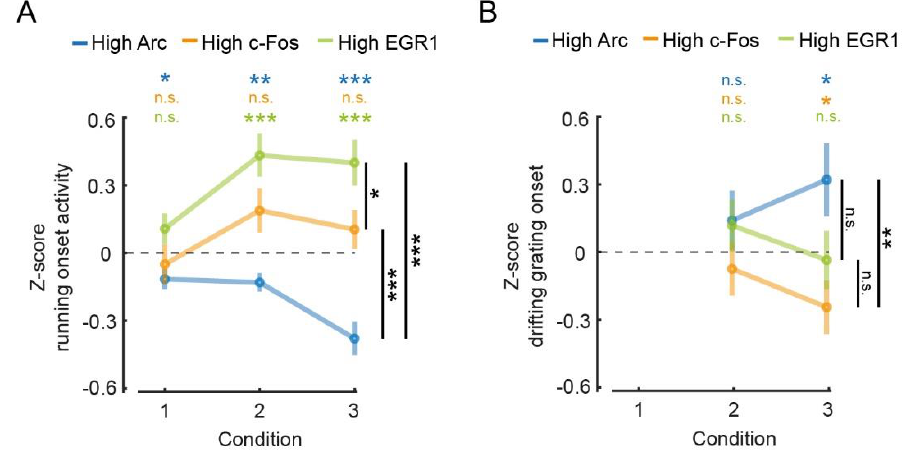
Figure 3. Differential relationship between IEG expression and motor-related and visual responses. ( A ) Average running onset response during darkness for the top 10 % IEG expressing neurons (Arc: 197 neurons, c-Fos: 189 neurons, EGR1: 121 neurons). Neuronal responses were pooled from all experimental sessions for each condition, subtracted by the mean and normalized by the standard deviation of the response of all neurons (Z-score). Error bars are SEM over neurons. Statistics above the plot indicate comparisons against 0, statistics to the right are between-group comparisons. n.s.: p > 0.05, *: p < 0.05, **: p < 0.01, *** p < 0.001, t-test. ( B ) Average grating onset response for the top 10 % IEG expressing neurons (Arc: n = 197, c-Fos: n = 189, EGR1: n = 121). Neuronal responses were pooled from all experimental sessions for conditions 2 and 3, subtracted by the mean and normalized by standard deviation of the response of all neurons (Z-score). Error bars are SEM over neurons. Statistics above the plot indicate comparisons against 0, statistics to the right are between-group comparisons. n.s.: p > 0.05, *: p < 0.05, **: p < 0.01, *** p < 0.001,